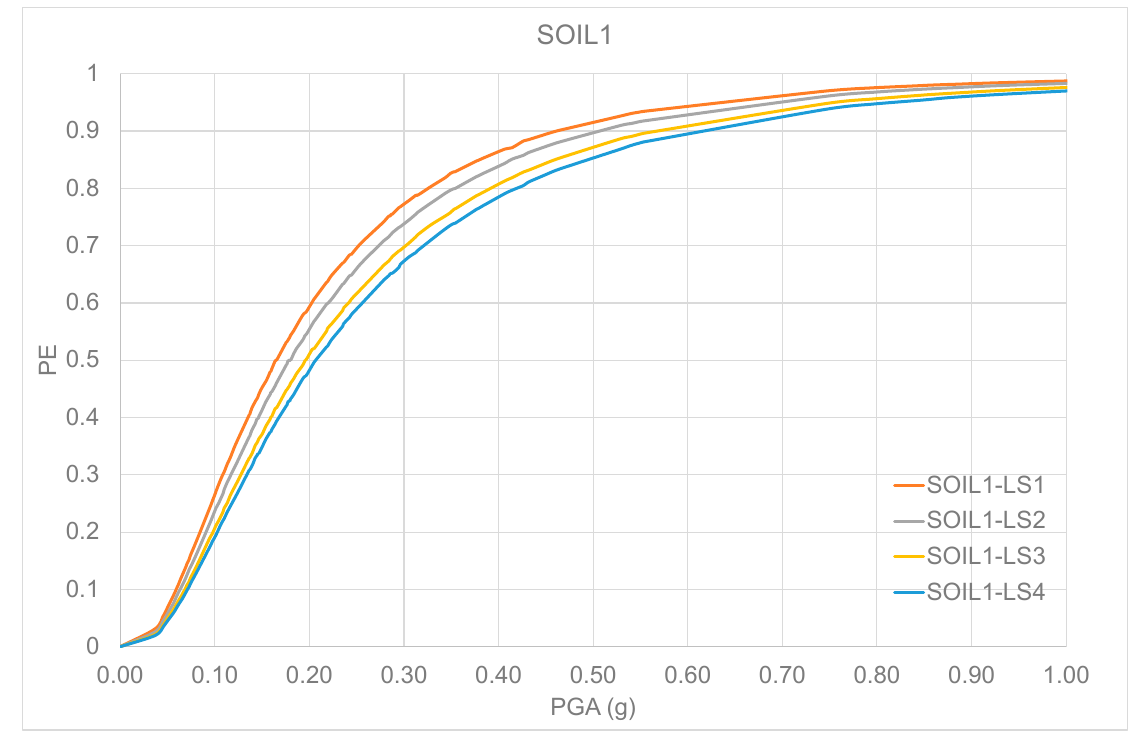
Figure 7. Fragility Curves: SOIL1.